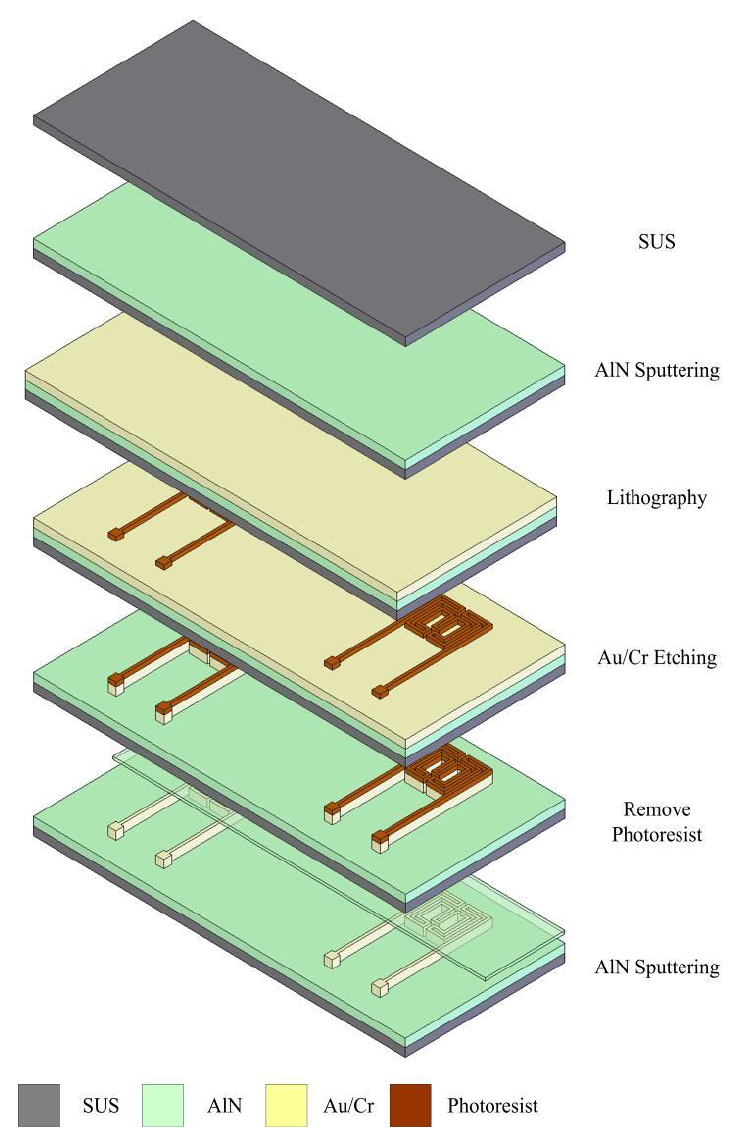
Figure 5. Process sketch of a micro temperature sensor.